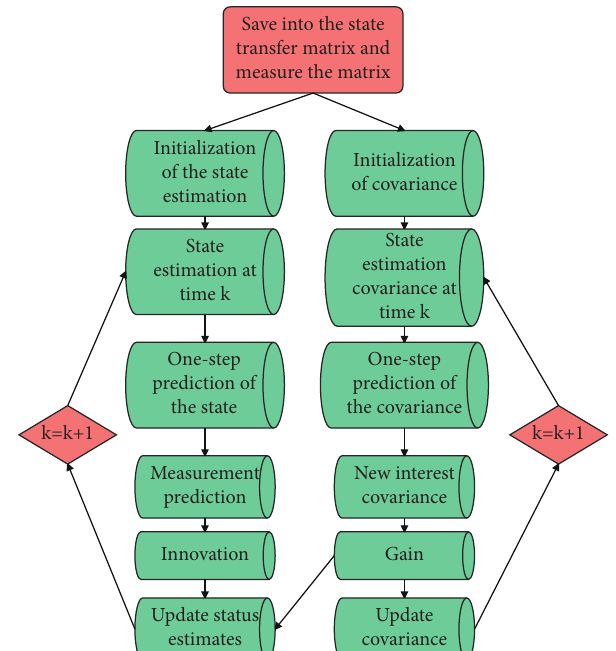
Figure 4: Flowchart of Kalman filter